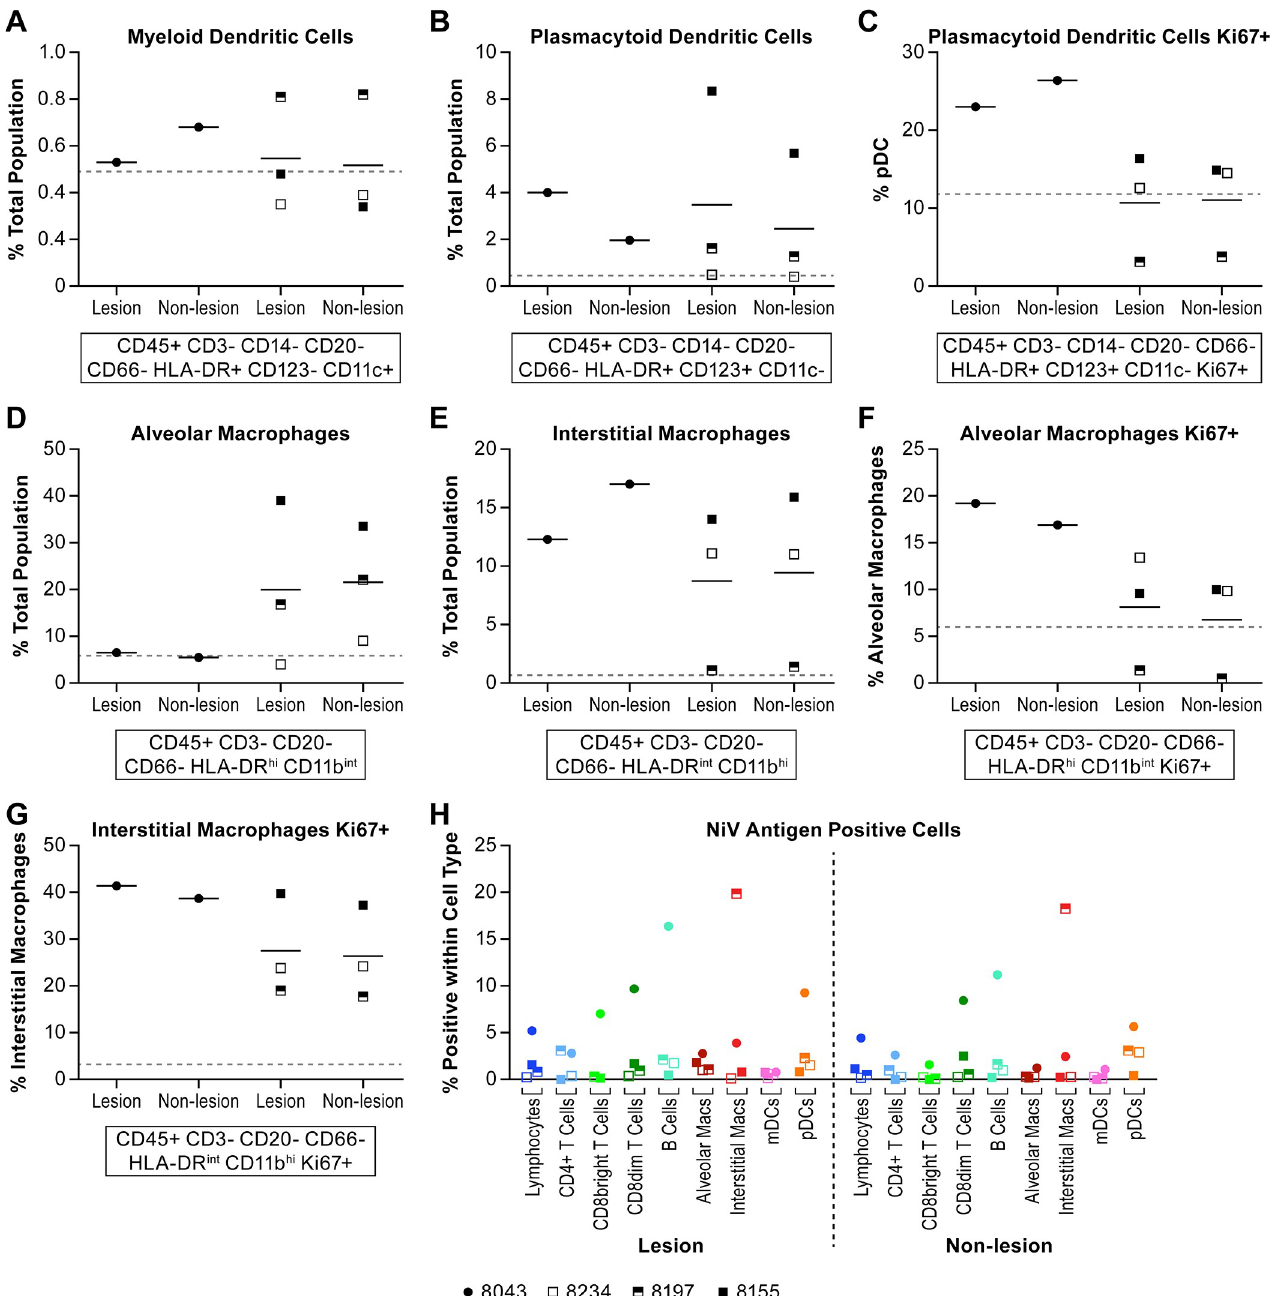
Fig 8. Antigen presenting cell populations in the lung. Flow cytometric analysis of populations of antigen presenting cells (APC) in the lungs of animals infected with NiV. Tissues were not collected from two animals due to tissue degradation. For each animal, samples from apparently unaffected tissue (non- lesion) and affected tissue (lesion) were collected. The specific markers used to distinguish APCs are indicated below the individual panels. Analyses included the Ki67 marker to determine if cell populations were proliferating. Animals included in this analysis included 8043 (filled circle), 8234 (open square), 8197 (half filled square) and 8155 (filled square). Individual cell populations included (A) myeloid dendritic cells (mDCs); (B) plasmacytoid dendritic cells (pDCs); (C) proliferating pDCs; (D) alveolar macrophages; (E) interstitial macrophages; (F) proliferating alveolar macrophages; and (G) proliferating interstitial macrophages. Cell populations isolated from the lung were also tested for the presence of NiV antigen (H). Markers and antibody clones used for these analyses can be found in S3 Table. The dashed horizontal line in panels A-G indicates the mean value of equivalent cell populations collected from two control animals. The solid lines in panels A-G represent the mean for that dose